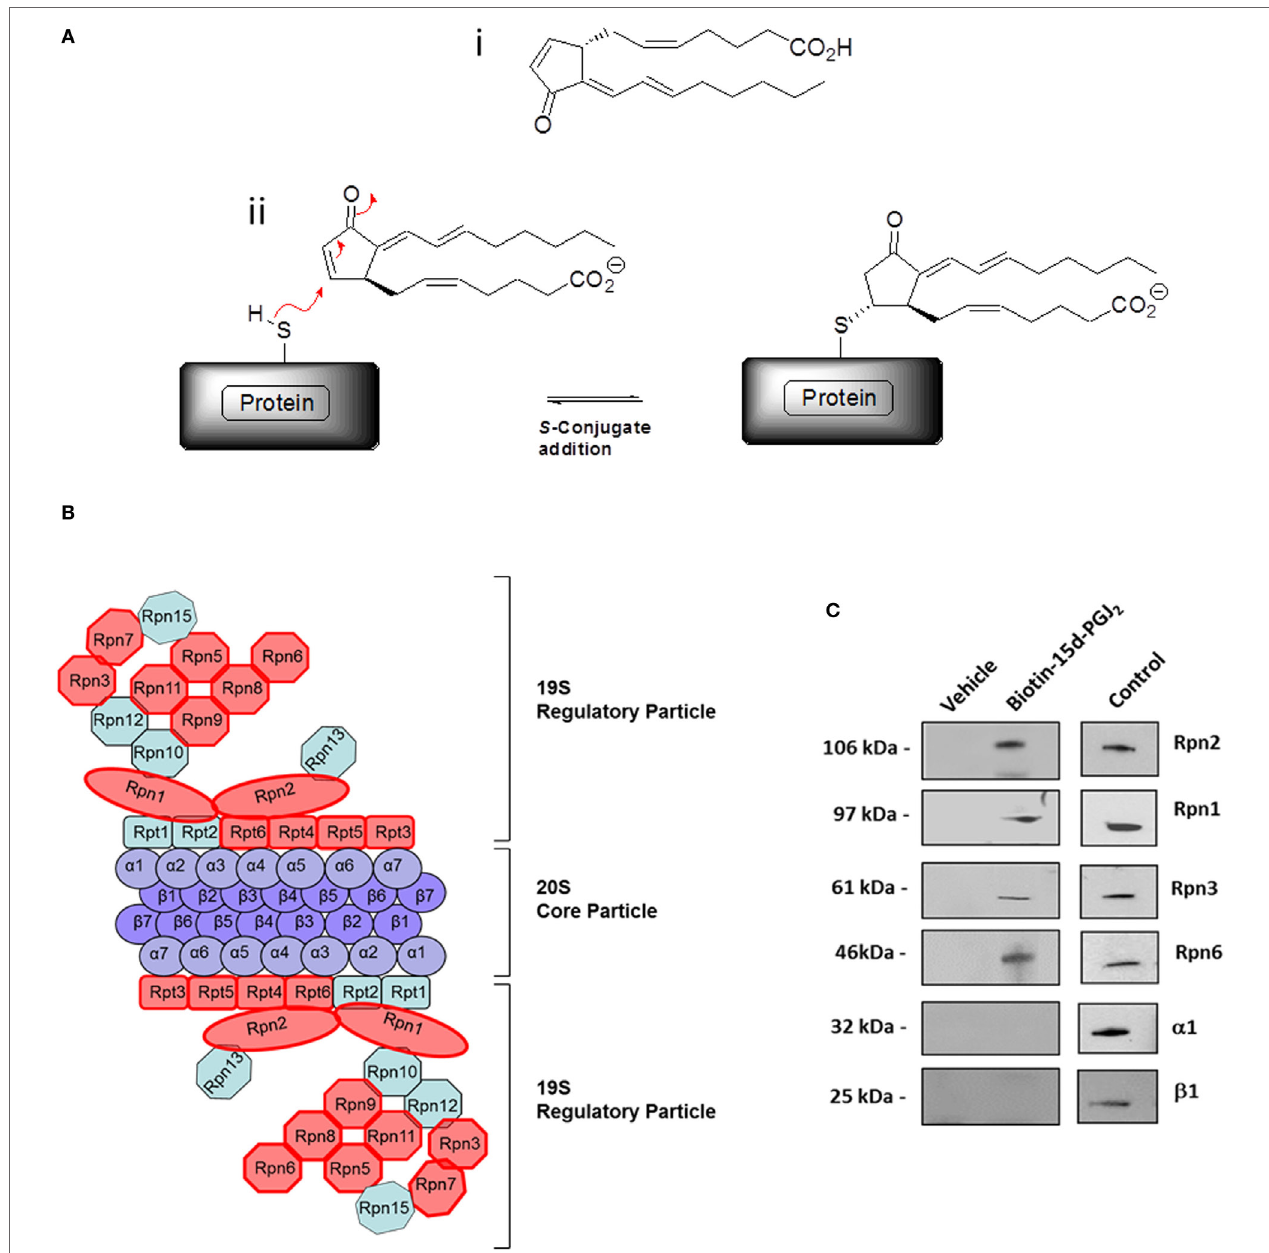
FigUre 1 | The proteasome complex is a target of 15d-PgJ 2 . (a) (i) Structure of 15d-PGJ 2 and (ii) mechanism of covalent modification of thiol-containing proteins by 15d-PGJ 2 via S-conjugate addition. (B) EC were incubated with 5 μ M biotin-15d-PGJ 2 and biotin-15d-PGJ 2 modified proteins were bound to neutravidin beads, analyzed by SDS-PAGE, and identified by LC–MS/MS (27). The red shapes in the schematic representation indicate the 13 proteins in the 19S regulatory particle modified by 15d-PGJ 2 . (c) Validation of MS results by Western blotting. EC were treated with or without 5- μ M biotin-15d-PGJ 2 , and the proteasome proteins were affinity-precipitated using anti Rpn1, Rpn2, Rpn3, and Rpn6 antibodies. Modification by biotin-15d-PGJ 2 was demonstrated by anti-biotin Western blot. Total cell lysates were used as positive controls (Control) for each antibody. Anti-20S proteasome antibodies ( α 1 and β 1) were used to show the localization of the 15d-PGJ 2 modification to the 19S regulatory subunits of the 26S